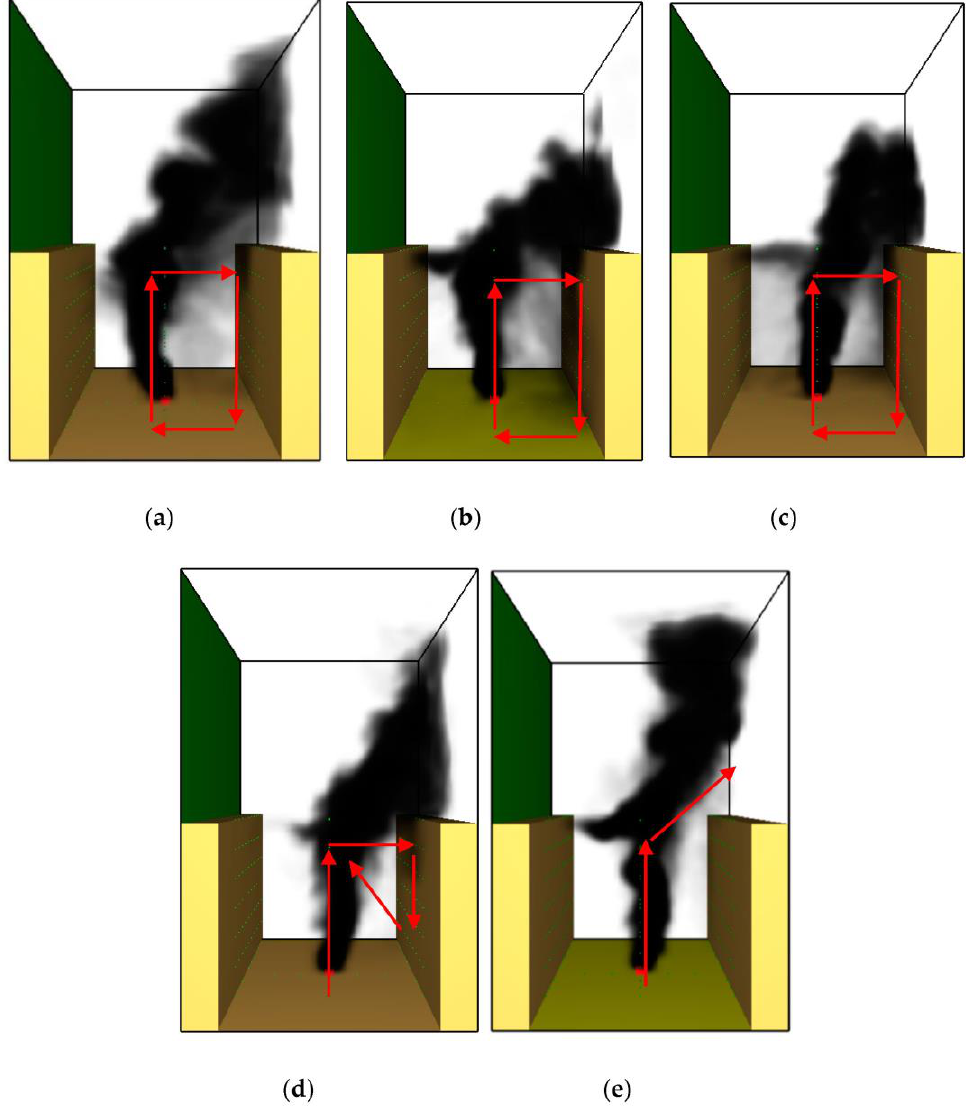
Figure 3. Typical 3D smoke-diffusion behavior for various wind directions at 400s: ( a ) θ = 0°, v = 2.8 m/s; ( b ) θ = 20°, v = 3.2 m/s; ( c ) θ = 35°, v = 3.5 m/s; ( d ) θ = 50°, v = 3.9 m/s; ( e ) θ = 65°, v = 10 m/s ( a –